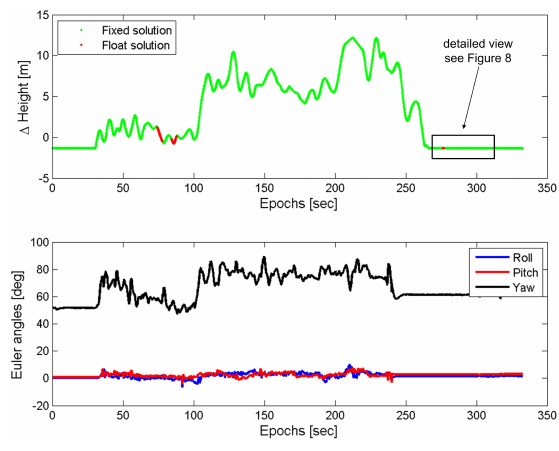
Figure 7: The height of the UAV is presented in the upper graph. In this, fixed solutions (integer ambiguities) are printed in green, while float solutions (real valued ambiguities) are printed in red. The bottom graph shows the roll, pitch and yaw angle of the UAV during the test flight.